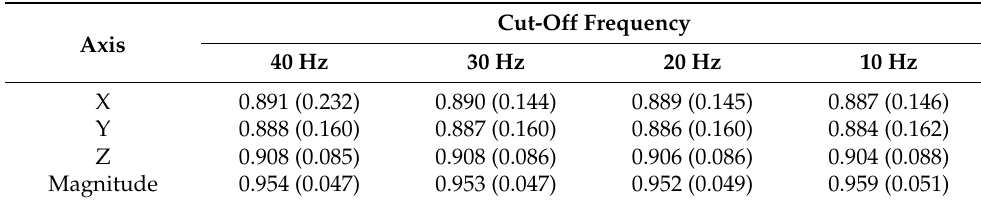
Table 5. Comparison between Polar and MetaMotionR values for features commonly used in activity recognition. Feature Polar MetaMotionR RMSE Mean Magnitude (G) Root Mean Square of Magnitude (G) Power of Magnitude (n.u.)